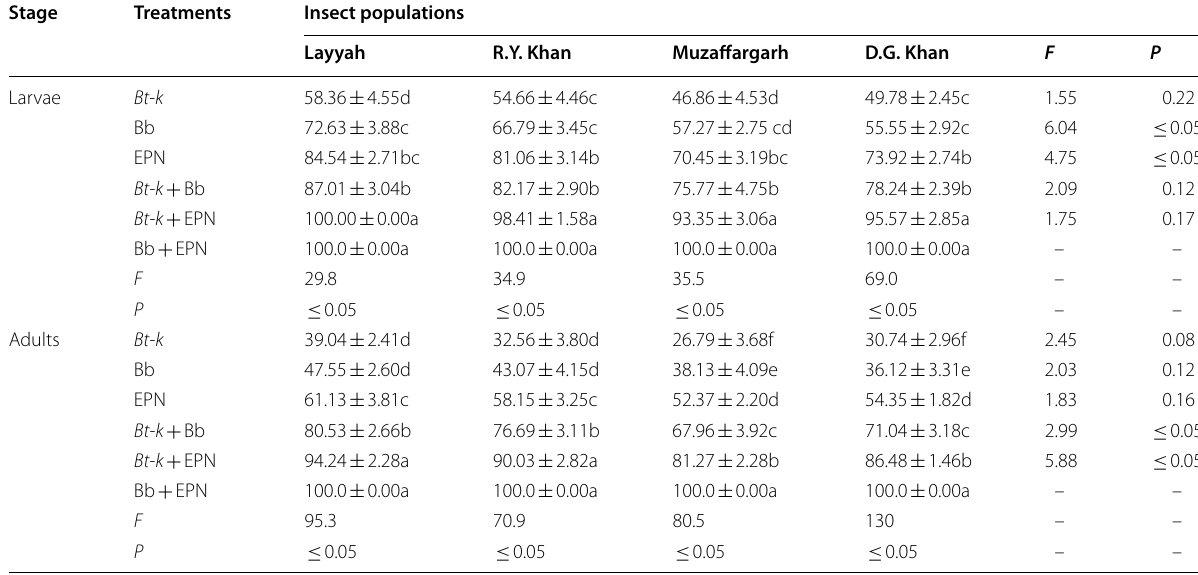
Mortality% followed by the same letter within each treatment and insect populations are not significantly different; HSD test P kurstaki , Bb: Beauveria bassiana , EPN: Heterorhabditis bacteriophora